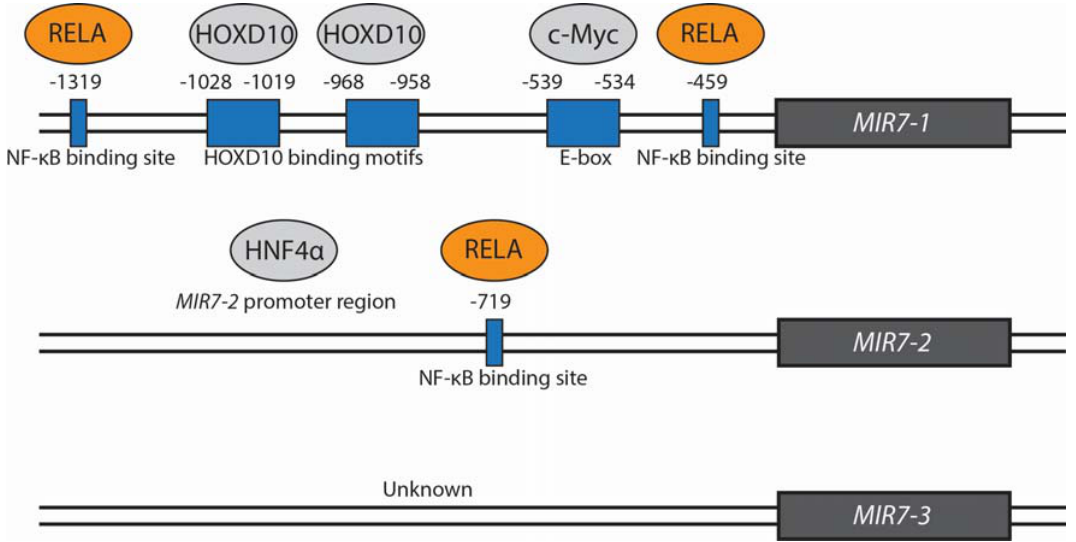
Figure 1. Transcriptional regulation of miR-7 by proteins confirmed to bind to MIR7 promoter regions. Those shown in grey positively regulate miR-7 expression while those shown in orange negatively regulate miR-7 expression. The transcription factors HOXD10 and c-Myc bind to and stimulate expression from the MIR7-1 promoter. HOXD10 may bind to two binding motifs − 1019 to − 1028 bp and − 958 to − 968 bp upstream of the MIR7-1 transcription initiation site [2]. C-Myc has been found to bind to an E-box motif at positions − 534 to − 539 bp upstream of MIR7-1 [8]. HNF4 α similarly binds and stimulates expression from the MIR7-2 promotor region. The exact location is not described [5]. RELA binds to three predicted NF- κ B binding sites at − 459 and − 1391 bp in the MIR7-1 and − 719 bp MIR7-2 promoters [31]. Proteins which bind and stimulate or inhibit expression from a MIR7 -3 promoter are currently